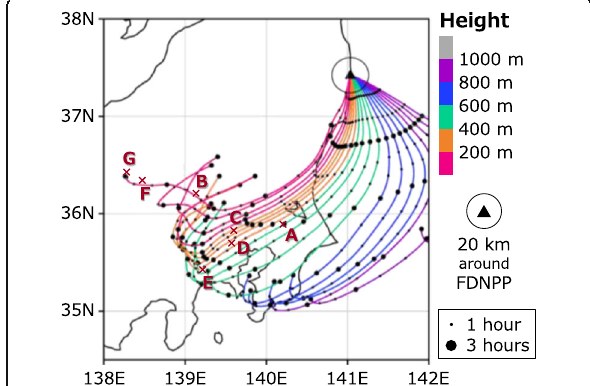
Fig. 5 Forward trajectories calculated for air parcels placed above the FDNPP at 0100 JST 15 March 2011. The trajectories are color- coded to distinguish heights (m) of the parcels at FDNPP. Small and large dots on the trajectories indicate intervals of every hour and 3 h since the calculation start time,